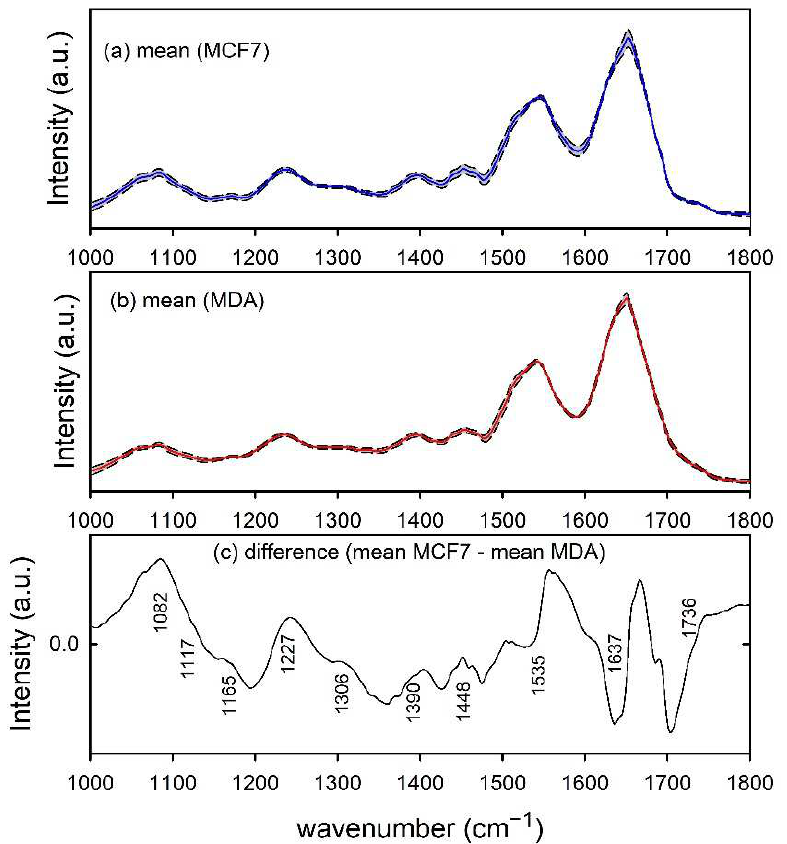
Figure 3. FTIR spectra of MCF7 ( a ) and MDA ( b ) cells. The mean spectra are reported by blue and red lines in ( a , b ), respectively. Standard deviation spectra are also reported as dashed lines and the grey area corresponds to spectral values between mean ± standard deviation values. The spectral differences between mean values are reported in ( c ) and the wavenumber values of spectral features mainly contributing to such a difference are labelled for clarity.